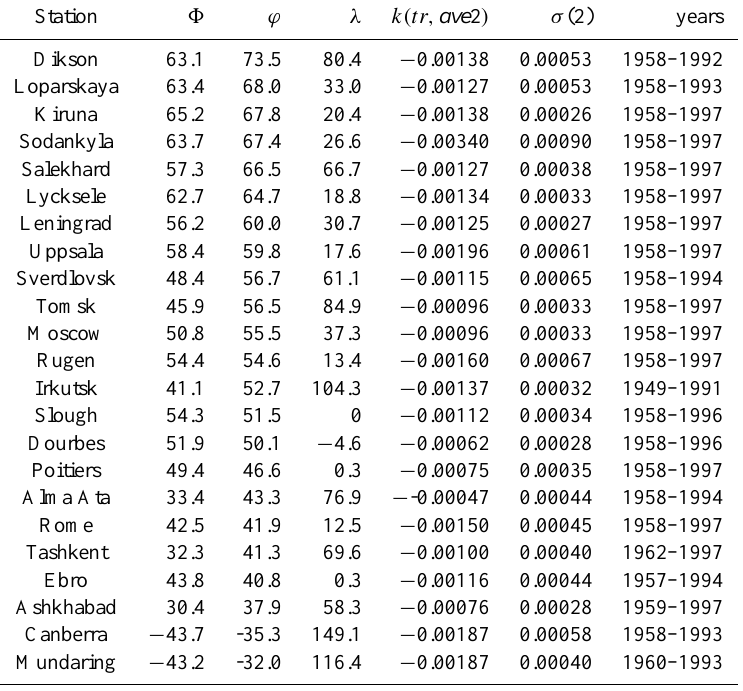
Table 3. The trends finally accepted for various stations